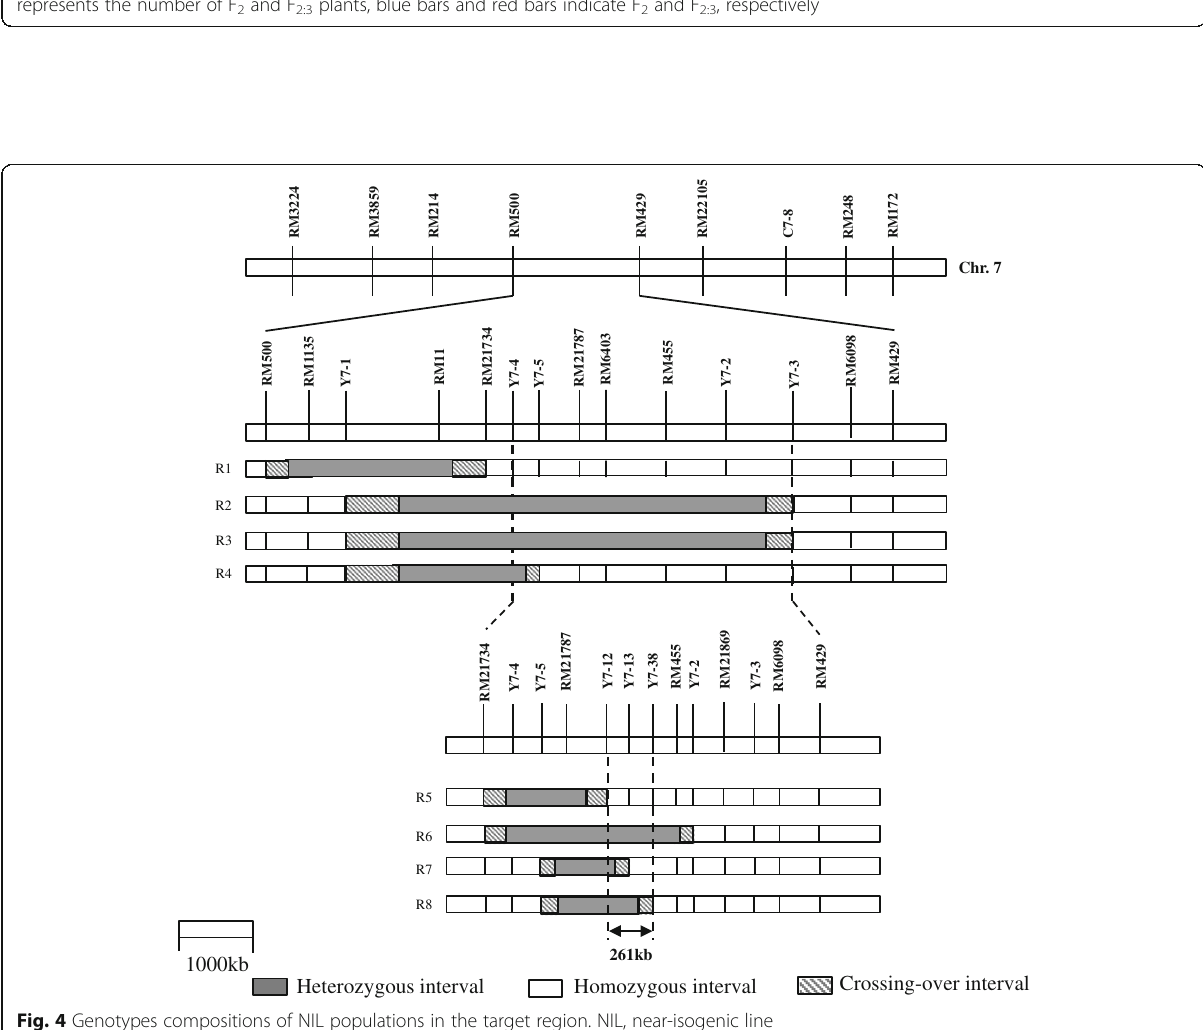
Fig. 3 Frequency distribution of five grain shape traits in the F 2 and F 2:3 populations. (P 1 : Nipponbare, P 2 : IL188). The vertical axis of each figure represents the number of F 2 and F 2:3 plants, blue bars and red bars indicate F 2 and F 2:3 , respectively